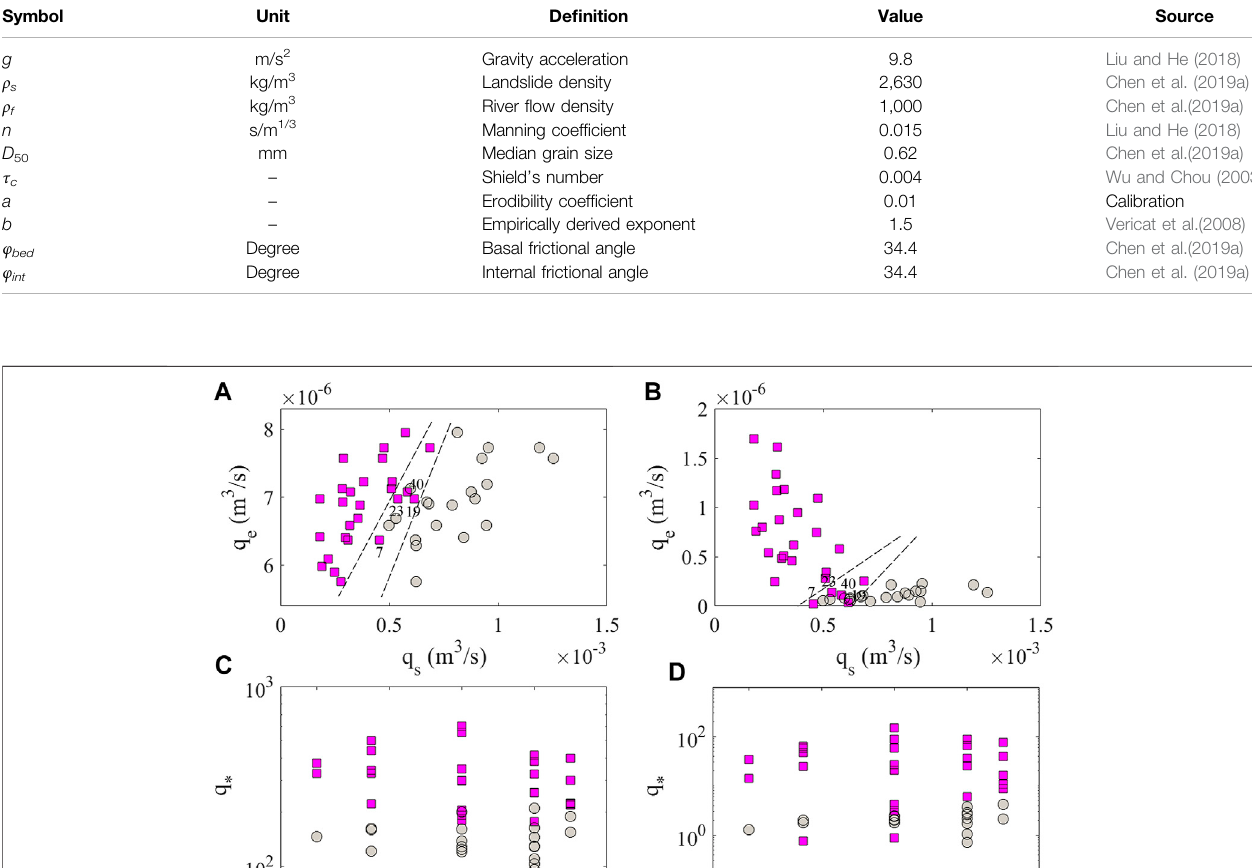
Frontiers in Earth Science |